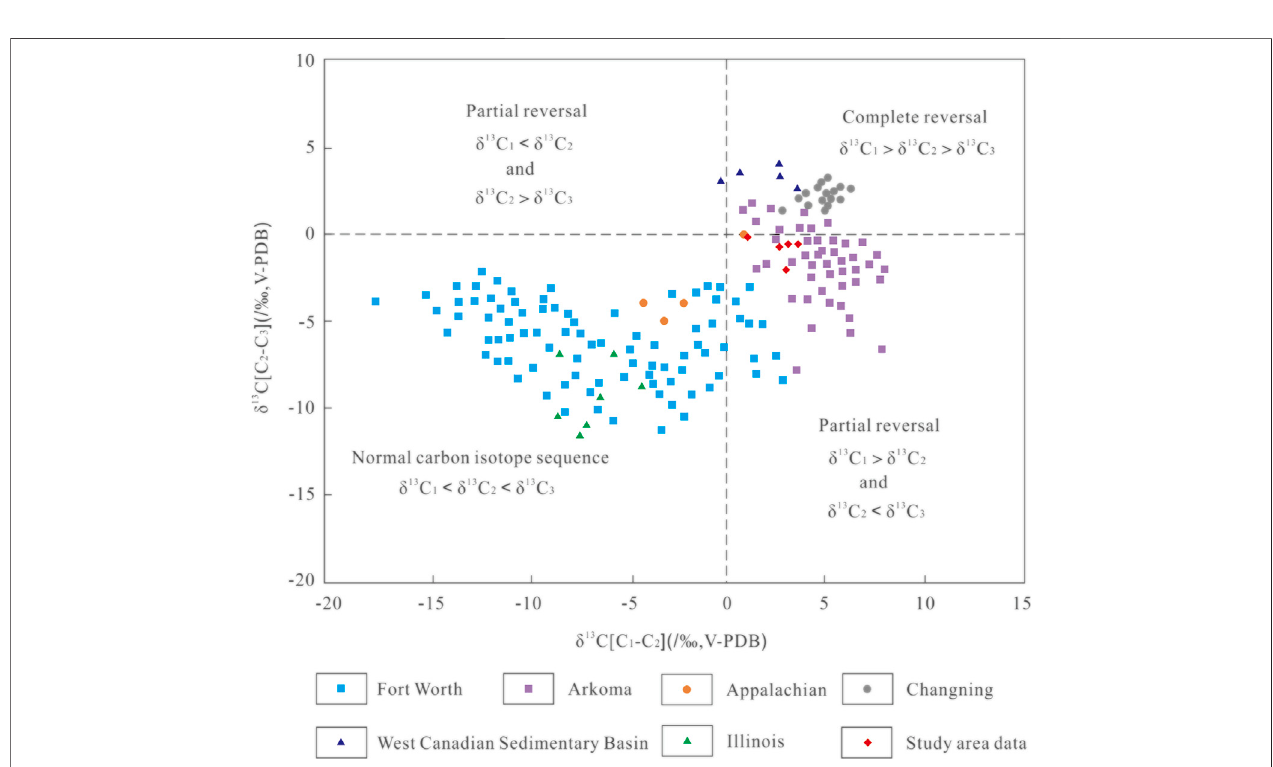
FIGURE5| Reversaldistributionmodeofcarbonisotopiccompositionofshalegas(modi fi edfromZumbergeetal.,2012;TilleyandMuehlenbachs,2013;Haoand Zou, 2013; Liu, 2015; Wu et al., 2015; Feng et al., 2016).